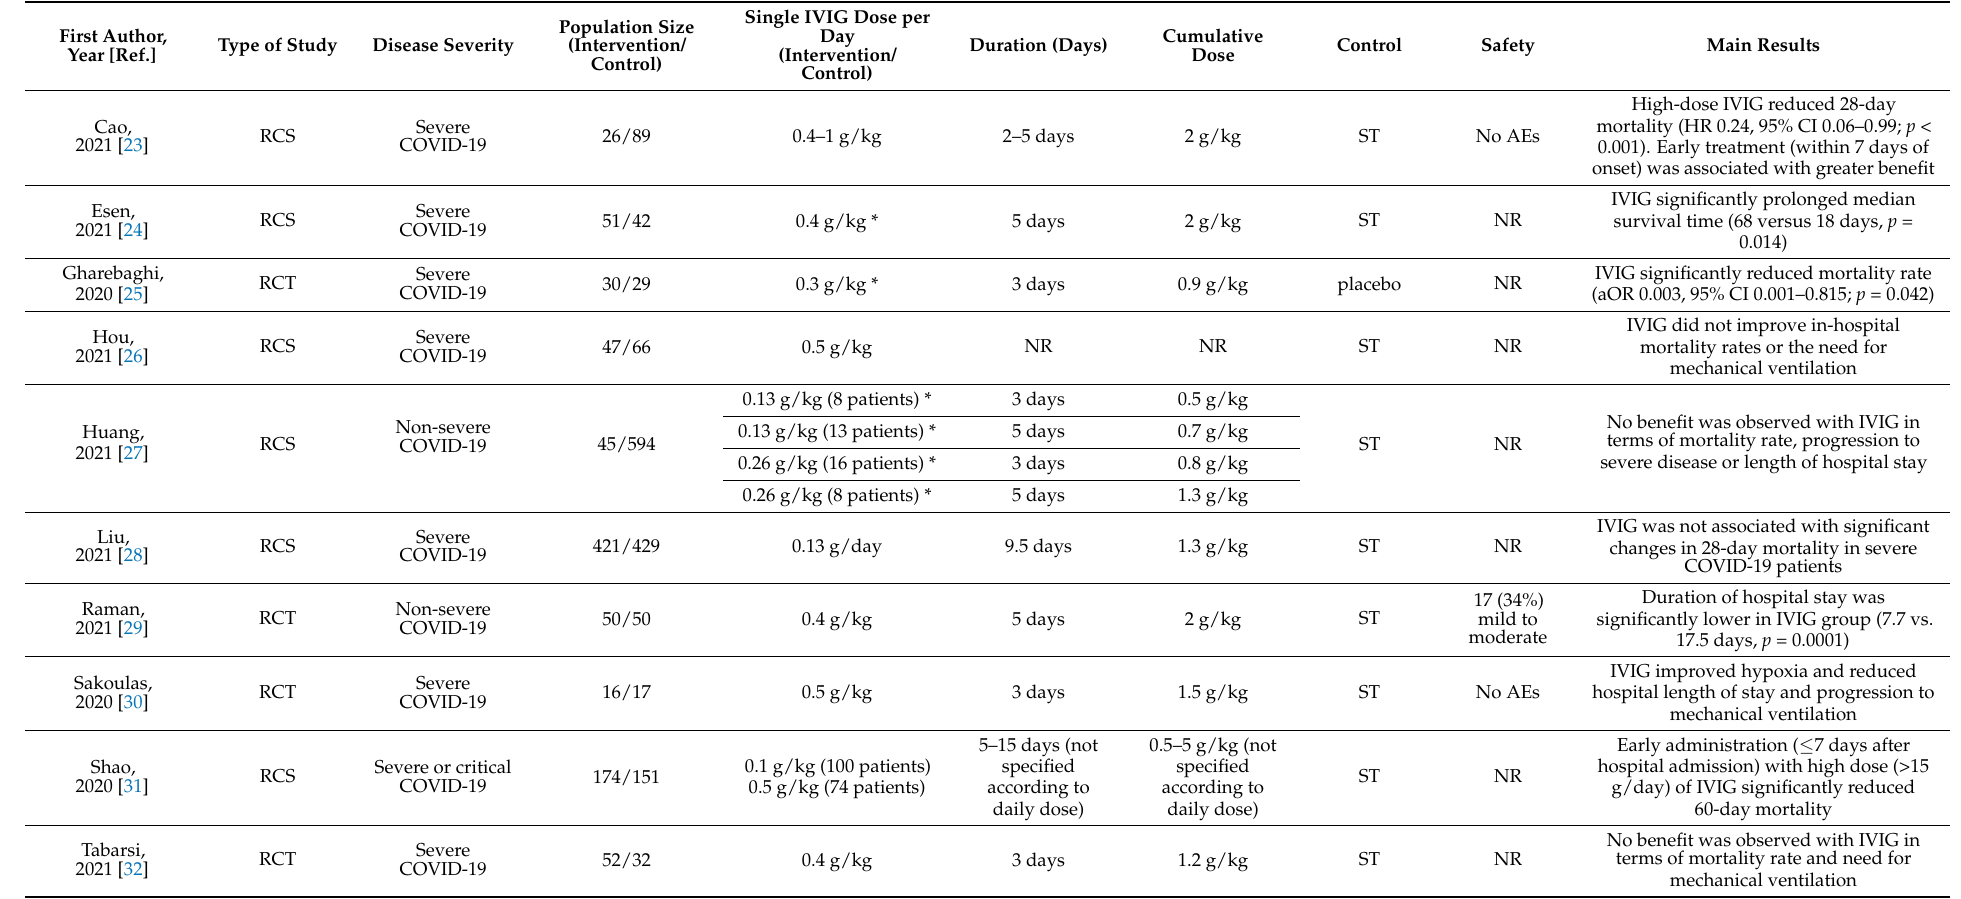
Table 1. Characteristics of the studies